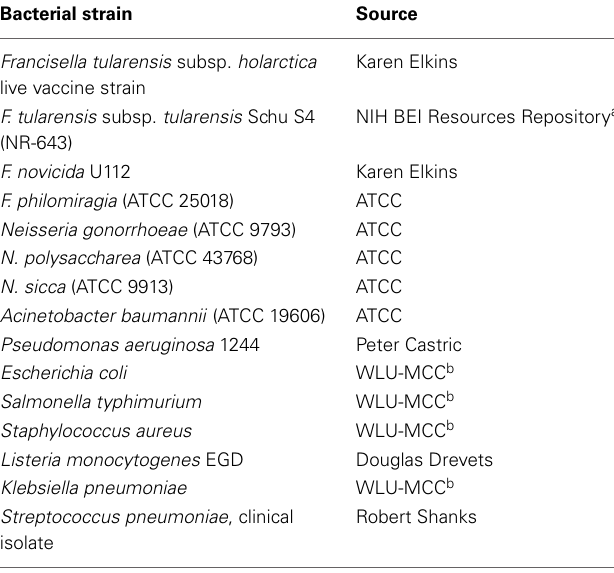
Table 1 | Bacterial strains used in this study. Bacterial